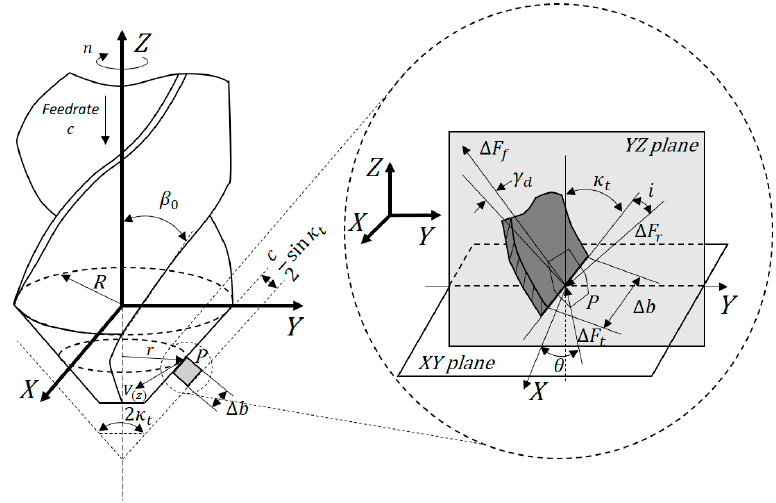
Figure 2. Mechanics model of a twist drill.